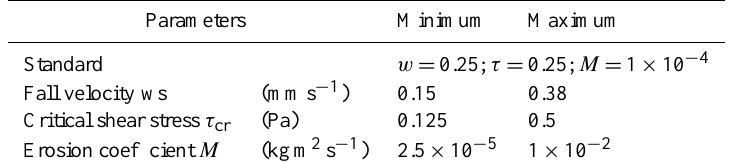
Table 1. Parameters set of sensitivity analysis.